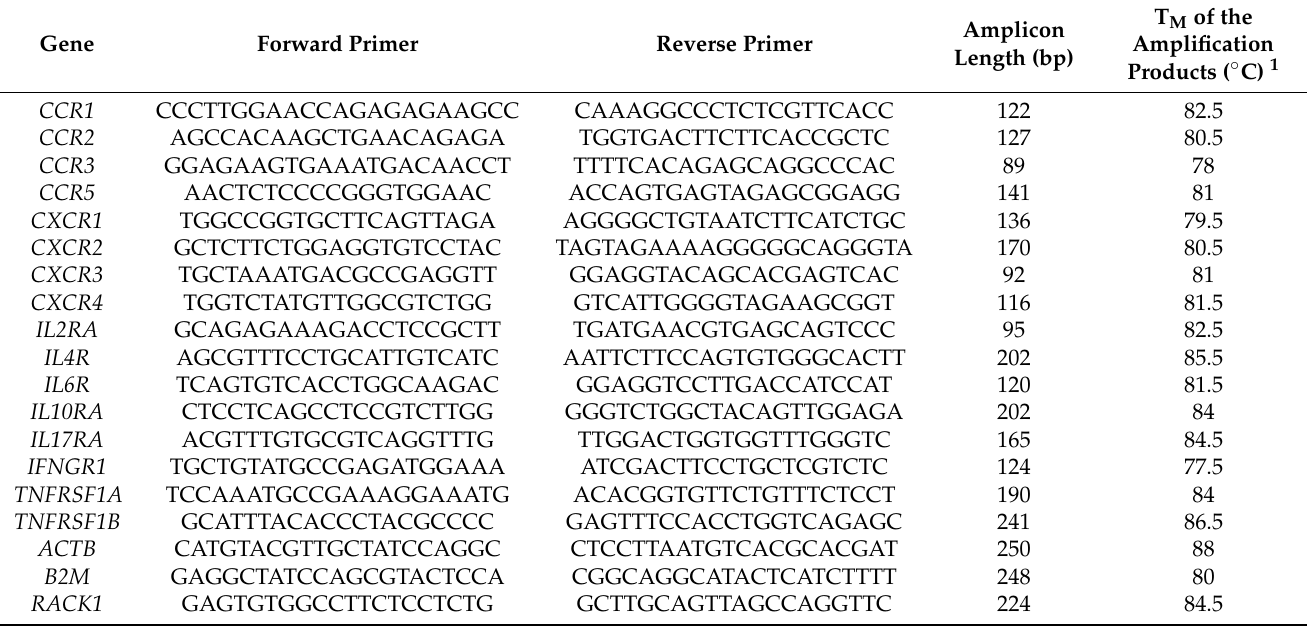
Table 2. qPCR primers used in this